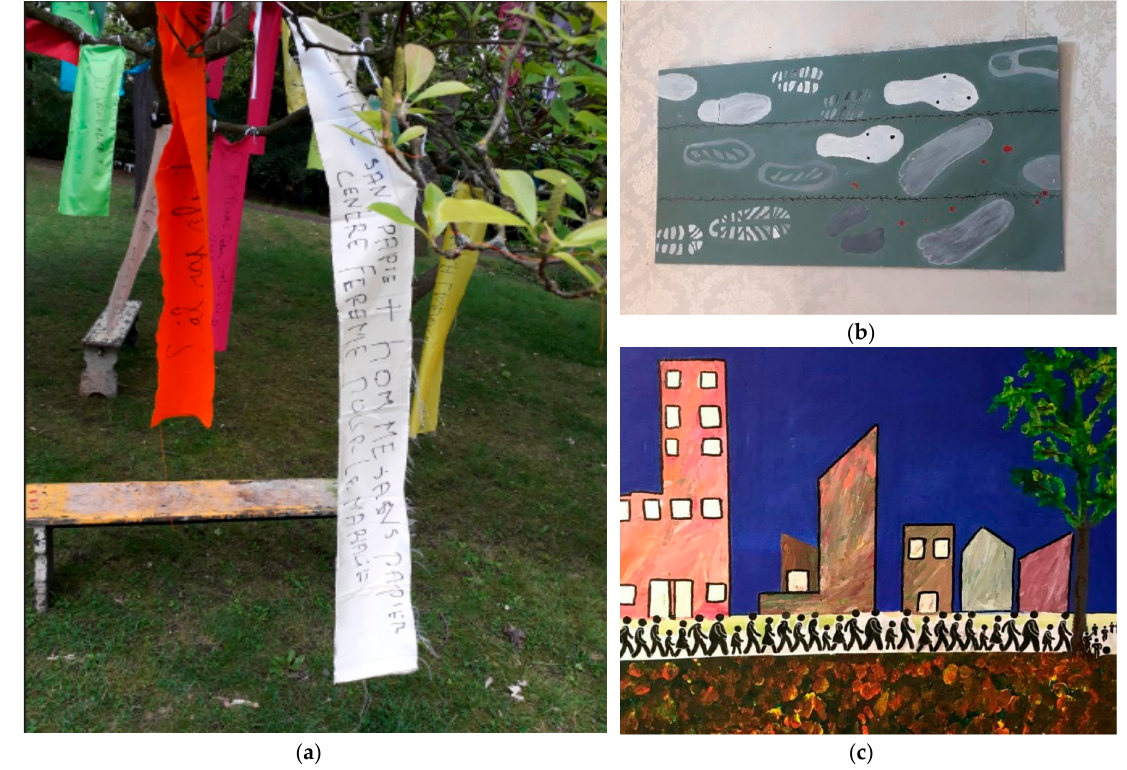
Figure 3. The tree of the “questions without answers” ( a ) and some paintings of the collective ( b , c ), Parcours d ’ artistes de Cointe, 20 May 2018 © Elsa Mescoli and La Voix des Sans-Papiers de Liège, used with permission.